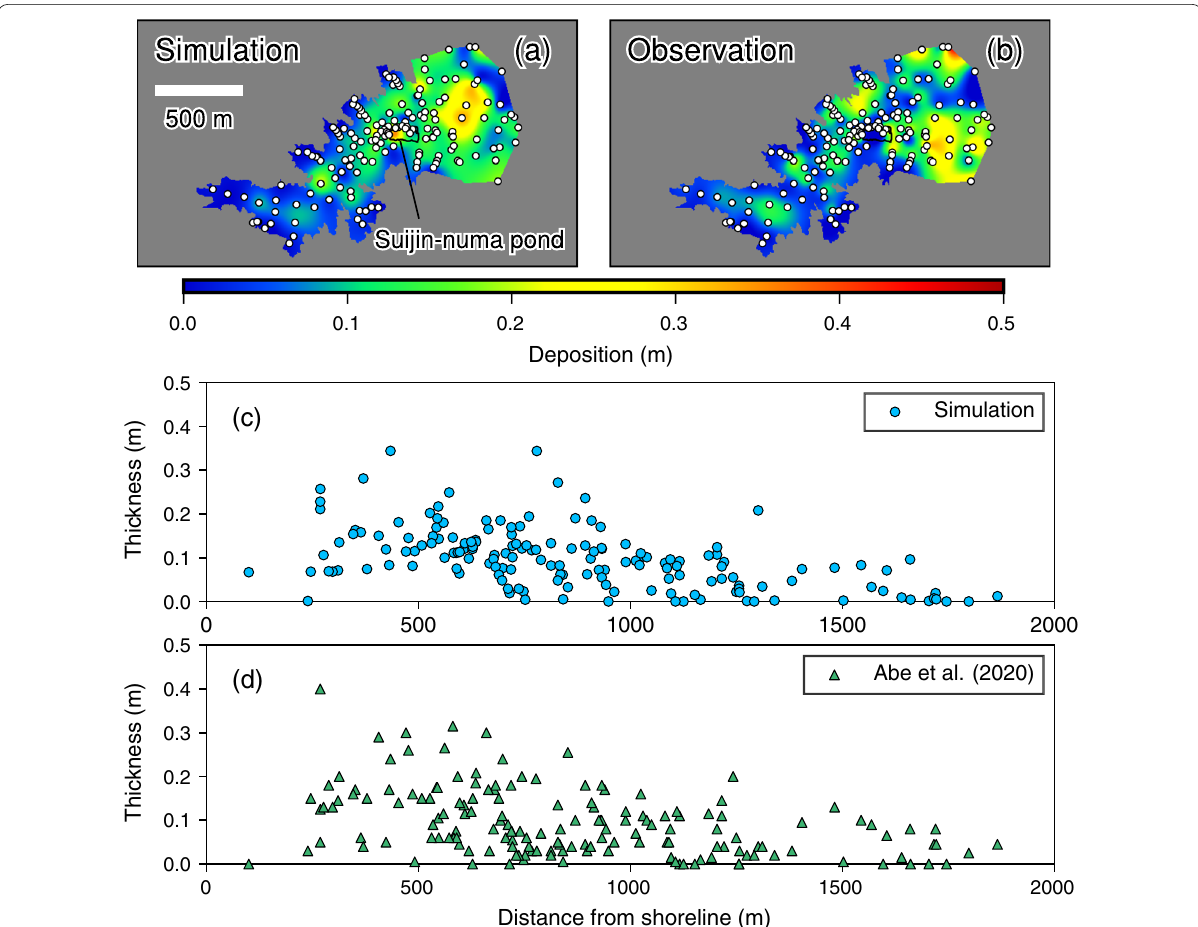
Fig. 2 Observed deposition and results of the sediment transport simulation for model and parameter validation (i.e., the reference simulation). a Thickness of the resampled and interpolated thickness based on the simulation. b Interpolated sand thickness distribution around the Suijin-numa pond. Thickness data were collected by Abe et al. (2020). c Shore-normal distribution of the simulated deposit thickness on the survey sites of Abe et al. (2020). d Shore-normal distribution of the observed deposit thickness (modified after Abe et al.